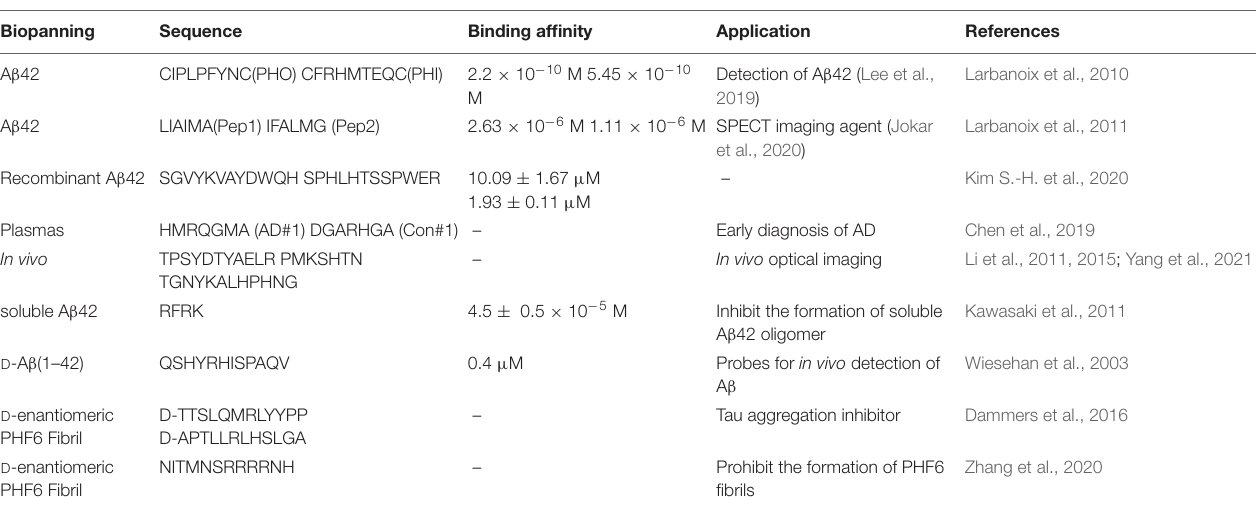
TABLE 2 | A β -targeting peptides identified from phage-display peptide